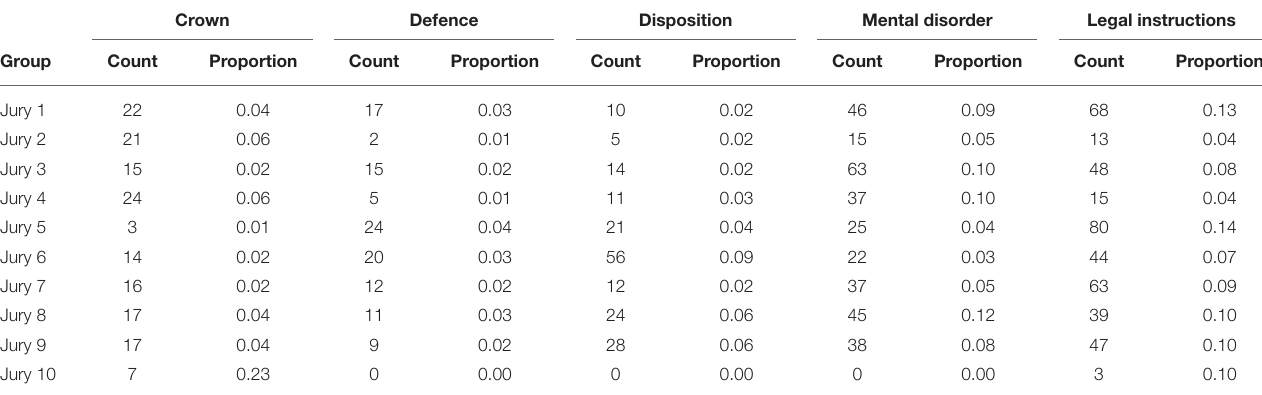
TABLE 3 | Rate of major topics (per total utterance count).